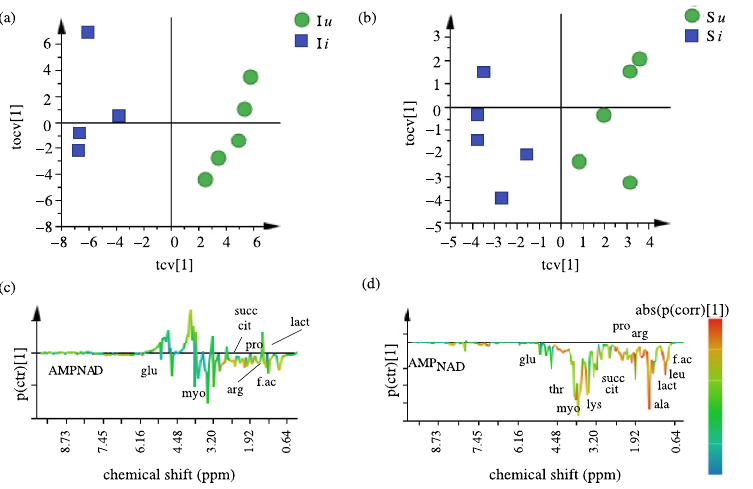
Fig 6. OPLS-DA analysis to see the effect of bacterial infection. (a) OPLS-DA score plot for I i -I u comparison, (b) OPLS-DA score plot for S i -S u comparison, (c) S-line plot for I i -I u comparisonand (d) S-line plot for S i -S u